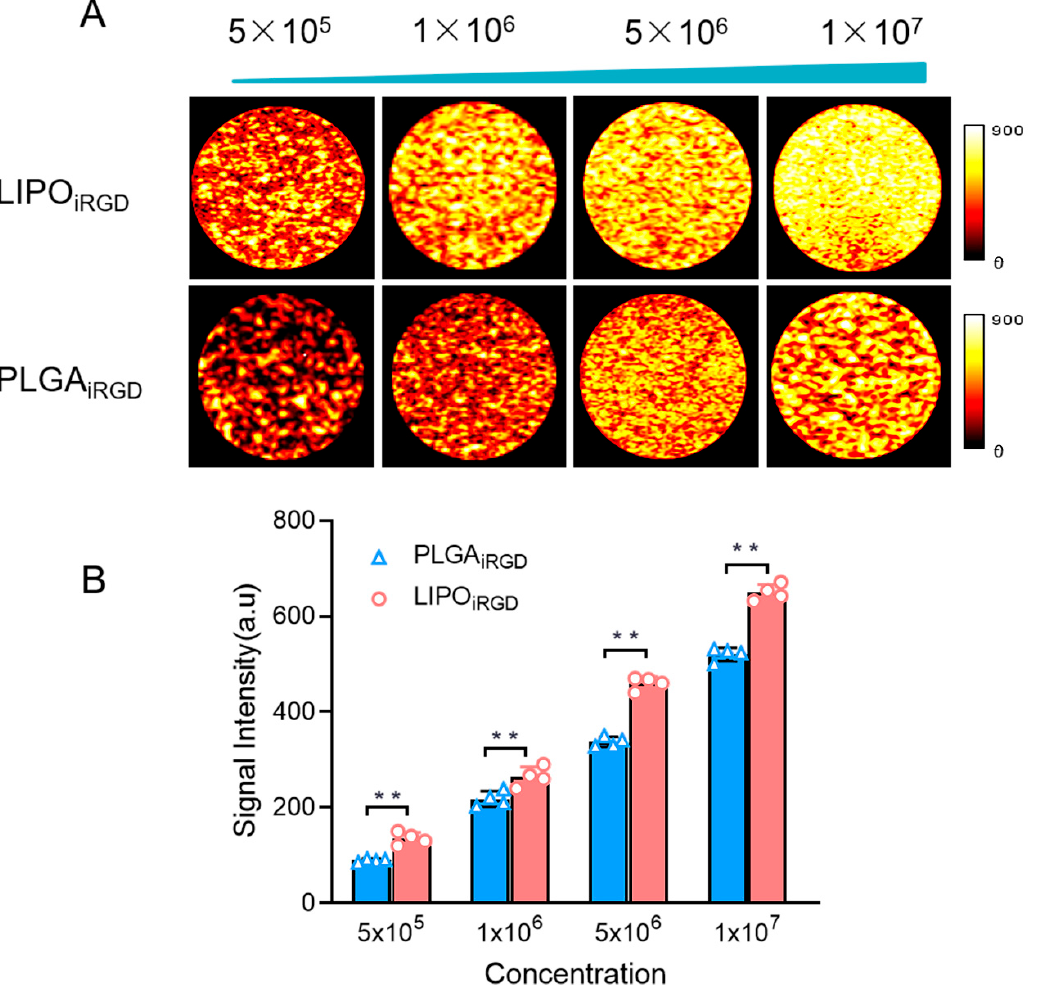
Figure 2. Characterization of LIPO iRGD and PLGA iRGD . ( A ) Representative ultrasound contrast images of LIPO iRGD and PLGA iRGD at the concentrations from 5 × 10 5 MBs/mL to 1 × 10 7 MBs/mL. ( B ) Quantitative analysis of US signal intensities of LIPO iRGD and PLGA iRGD . Data were analyzed by independent sample t -test (** p < 0.05 ).